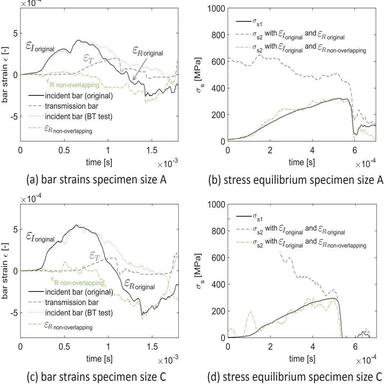
Bar strain wave group of an SHTB DENT test and dynamic stress equilibrium check for representative GFRP DENT specimens of size A (a and b) and C (c and sd).